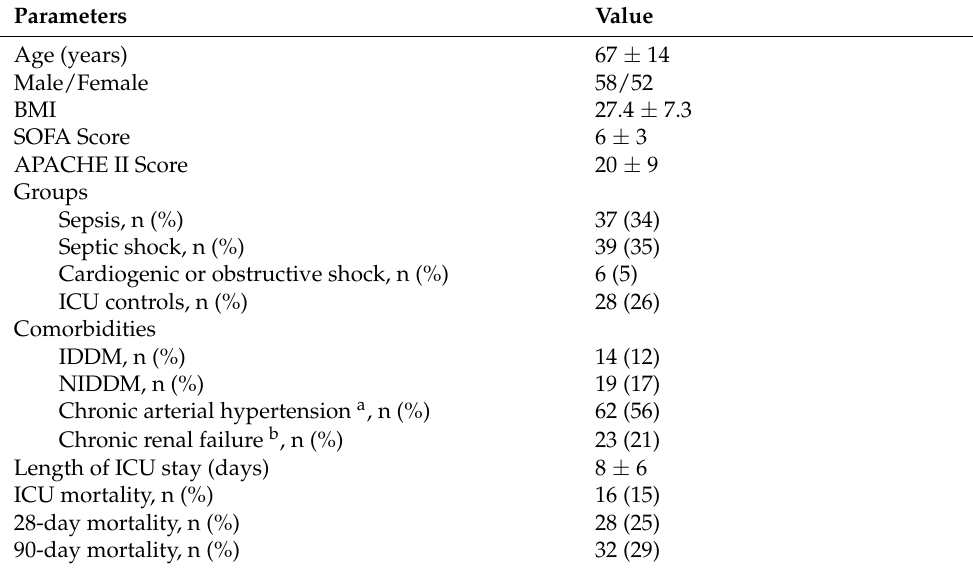
Table 1. Clinical data for all patients (n = 110).